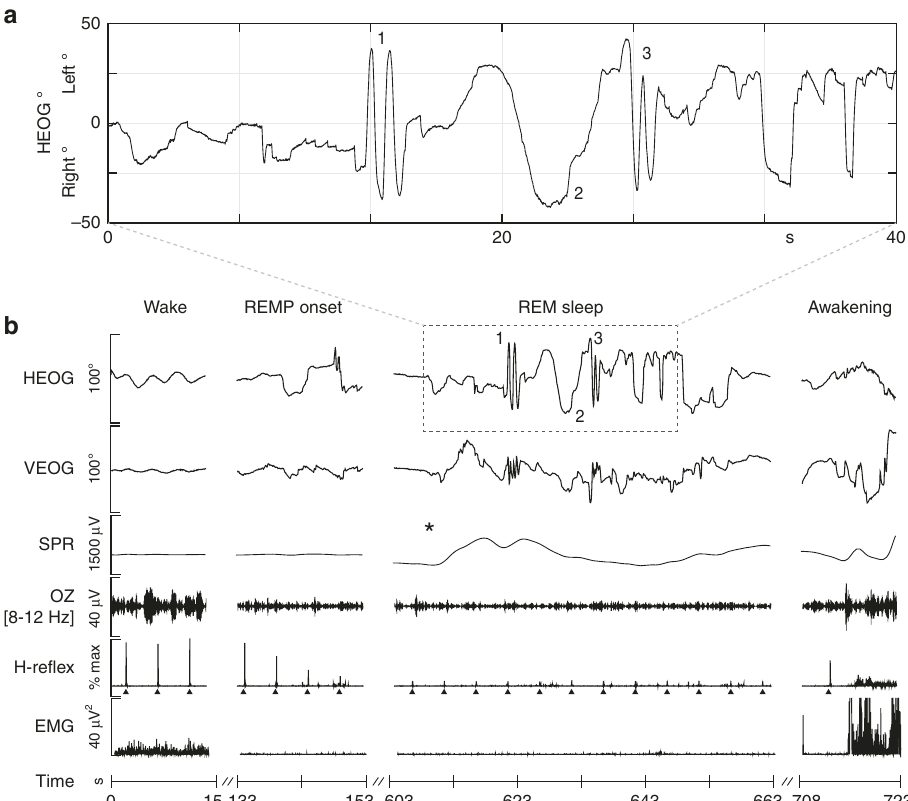
Fig. 1 Line tracking during lucid REM sleep dreaming in a single participant. a Enlarged section showing LRLR eye movement signals and smooth tracking task as recorded in the horizontal EOG (HEOG). Upon awakening, the subject reported becoming lucid in the dream, making a LRLR signal (1), fully extending his right thumb, and tracking his thumb nail as he slowly swung his arm horizontally from center to approximately 30° left, back through center to 30° right, and fi nally leftward back to center. While tracking to the right, he noticed moving his head slightly in the direction of tracking both rightward and leftward as he reversed motion back to the center (2). He marked the end of the smooth tracking task (estimated 10 s) with a second LRLR signal (3). Having completed the task, he spent the remainder of his lucid dream exploring the dream environment, waking approximately 60 s later. See Supplementary Note 1 “ Report of line tracking task ” for the report associated with this fi gure. b Six channels of physiological data (HEOG, vertical EOG (VEOG), skin potential response (SPR)), occipital EEG bandpass fi ltered for alpha (OZ (8 – 12 Hz)), H-re fl ex amplitude (a measure of spinal re fl ex excitability) (upward black triangles mark H-re fl ex STIM), and electromyogram (EMG)) are shown during an initial period of wakefulness, REM period onset (REMP onset), transition to lucid REM sleep and awakening. Suppression of EMG and H-re fl ex amplitude along with reduced alpha in EEG con fi rm that the participant remained in uninterrupted REM sleep during lucid dreaming, including LRLR signals and during completion of the slow tracking task. Lucid dream onset is localized by the autonomic nervous system surprise response (scalp skin potential response (SPR; black asterisk)) before the LRLR